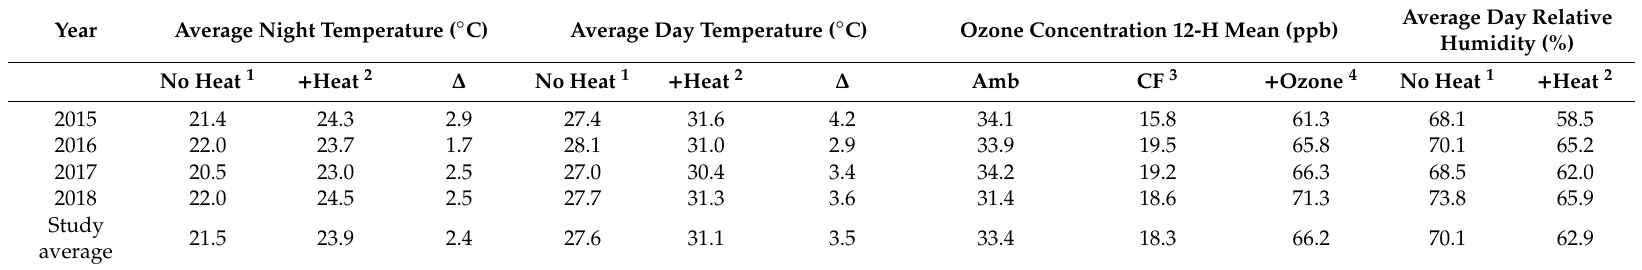
Table 1. Summary of Environmental Conditions. Values are seasonal means.